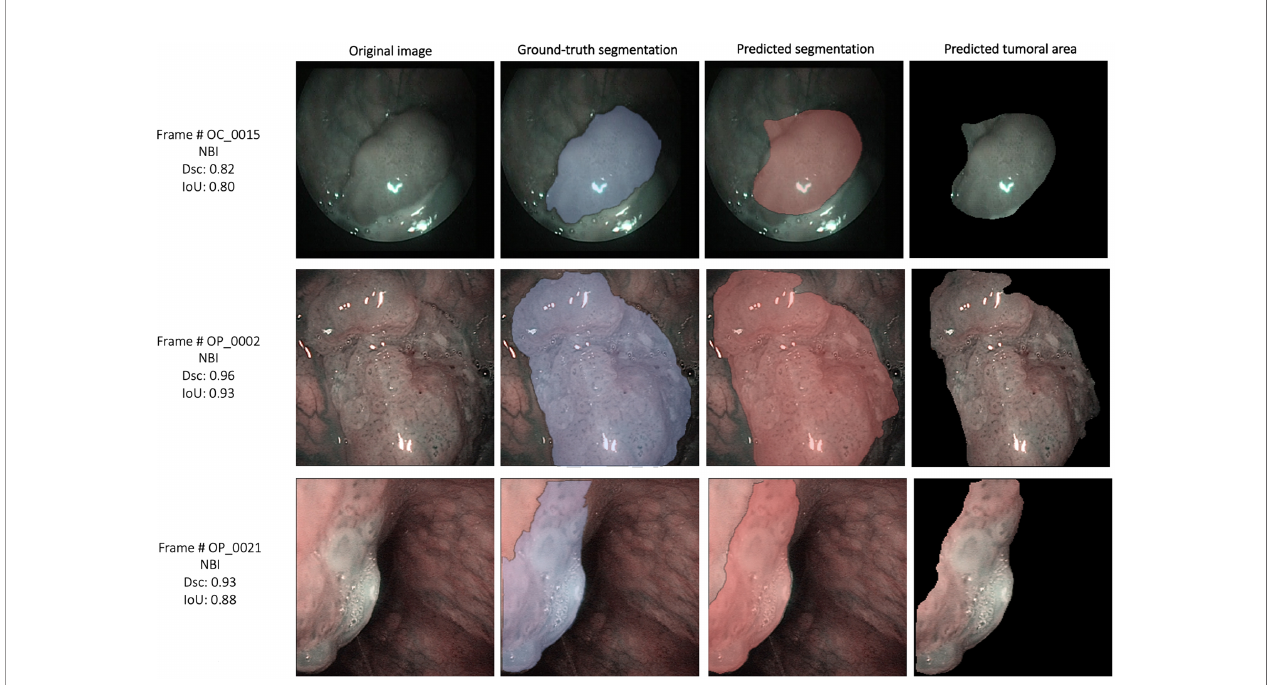
FIGURE 9 | Examples of automatic segmentation results for the oral cavity and oropharyngeal squamous cell carcinoma datasets using SegMENT + ensemble in- domain transfer learning. DSC, Dice similarity coef fi cient; IoU, intersection over union; NBI, Narrow Band